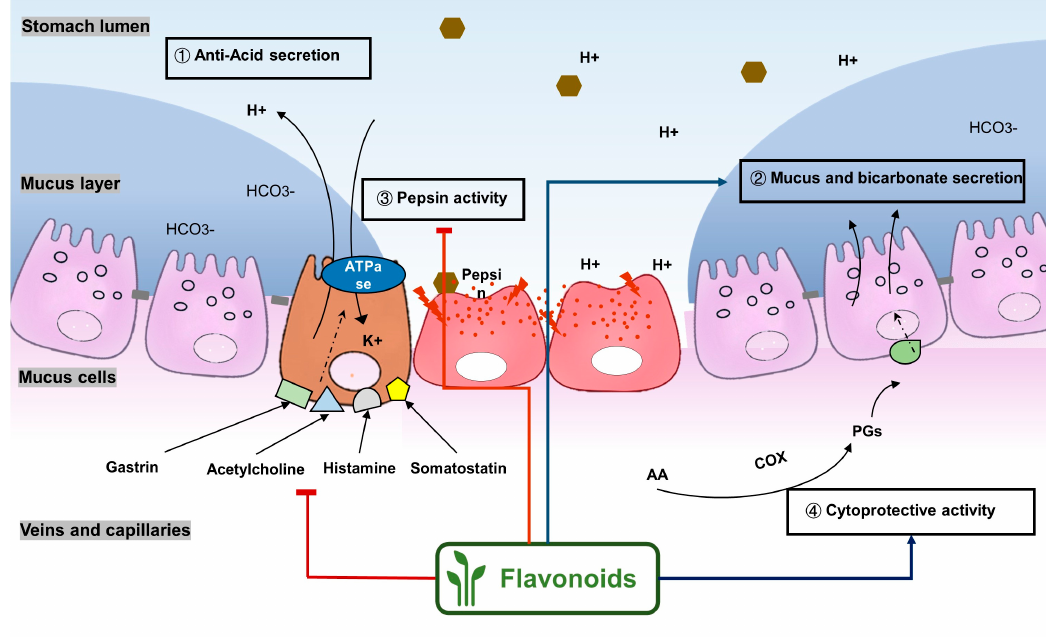
Figure 3. Flavonoids exert anti-ulcer effects through regulating gastric secretion pathways and prostaglandin levels. Flavonoids ( 1 ) decrease acetylcholine, gastrin, histamine, and somatostatin levels and inhibit H + K + -ATPase activities, therefore inhibiting gastric acid secretion; ( 2 ) promote mucus and bicarbonate secretion; ( 3 ) inhibit pepsin activity; ( 4 ) exhibit cytoprotective activity by regulating prostaglandin levels.